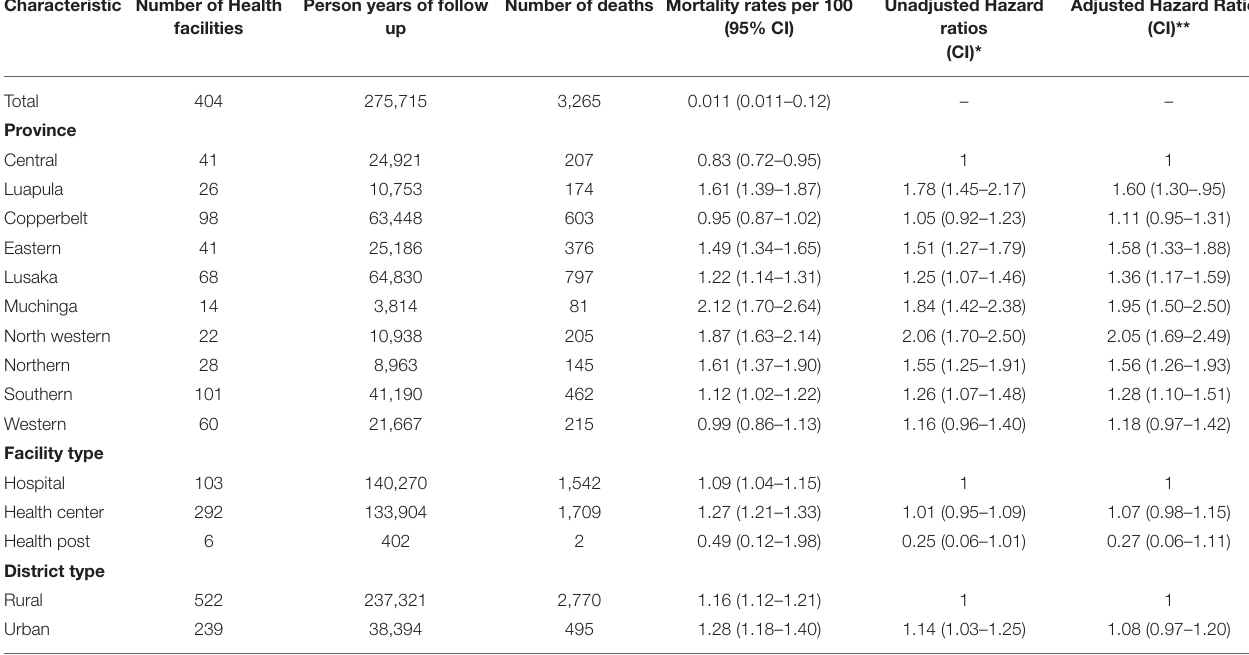
TABLE 2 | Hazard ratios for CLHIV on ART by province and facility types in